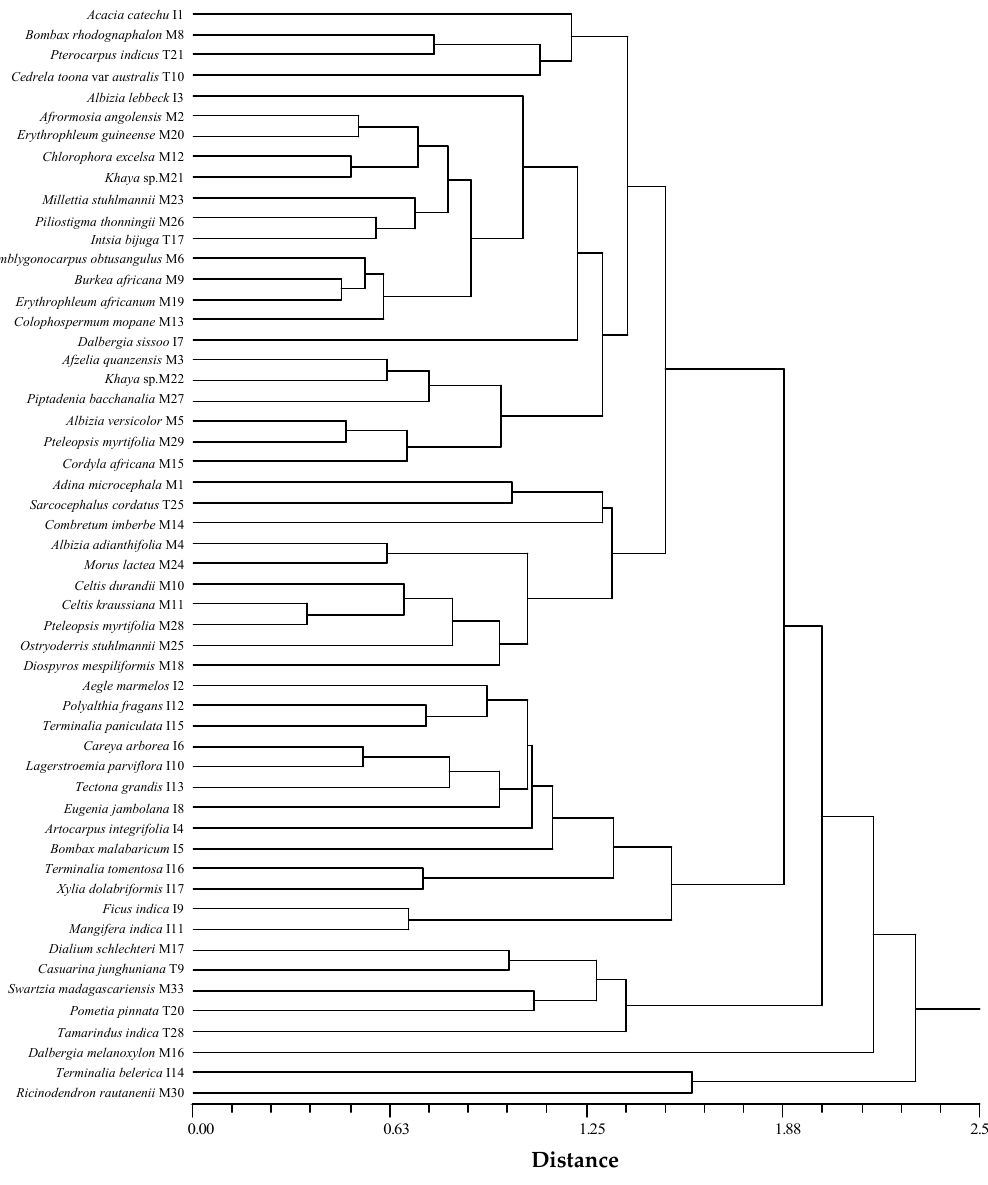
Figure 4. Classification of 54 tropical species (listed in Tables 1 and 3) based on 14 physical wood characteristics (coded in Table 2), obtained by the UPGMA clustering method (c = 0.720). The Artocarpus integrifolia from India (I4) and East Timor (T4) were found to be con- Cumulatively, PCs 1–3 explained 72.3% of the total variance of 54 wood species (Ta- nected to species from different genera: Tectona grandis (T29) and Sarcocephalus cordatus ble 5). PC1 explained 30.1% of the variation, and the variable with the highest loadings (T25), was the axial shrinkage coefficient (FIS12), in opposition to the other shrinkage characters (volumetric shrinkage, FIS5; tangential shrinkage, FIS6; radial shrinkage, FIS7; the volu-